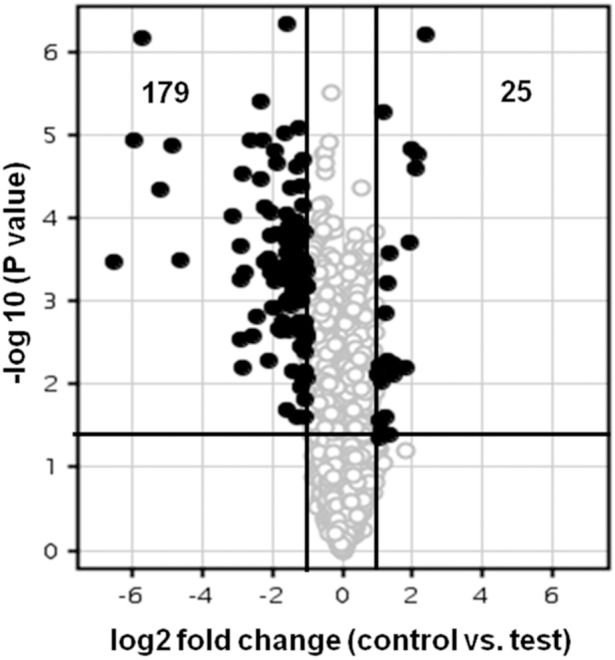
DNA microarray analysis of long-term stationary phase-induced gene expression in E. coli grown in LB broth.The Volcano plot depicts gene expression in 28 days old E. coli culture at 0.8 OD (OD600nm) cultured in LB broth compared to the freshly grown stationary phase E. coli culture control. Genes that are represented on the right side of the volcano-axis are up regulated and those that are on left side of the axis are down regulated. Out of the 4377 genes (O) analysed, 25 genes were up-regulated (•) and 179 were down regulated (•). Only those genes that showed more than 2.0 fold change in expression and a P value <0.05 were identified as either up- or down-regulated. The X-axis represents the log2 fold change and the dark vertical lines represent cut-offs at 2.0 fold decrease and increase. The y-axis represents the p-values and the dark horizontal line indicates a –log10 p value cut-off of 0.05.